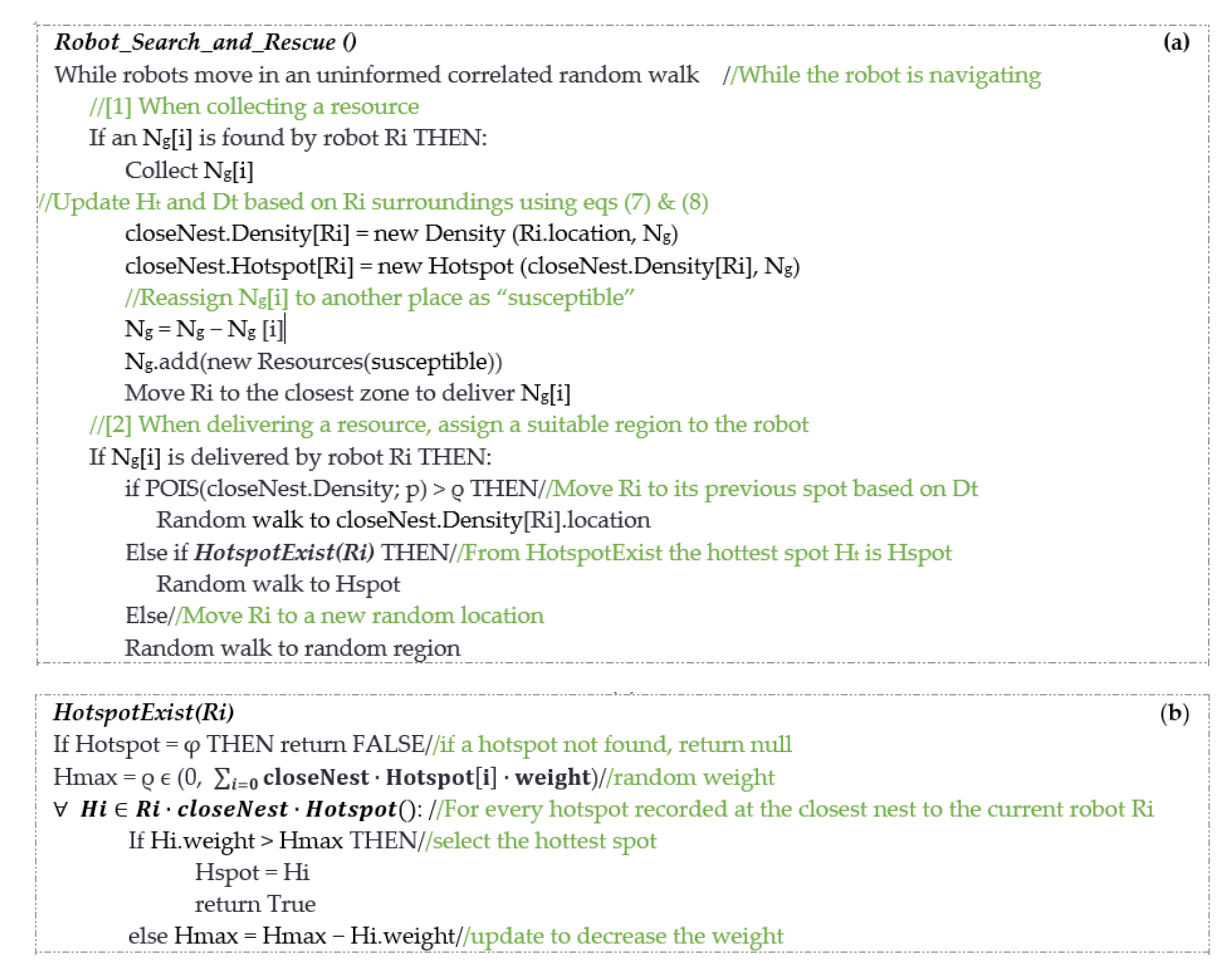
Figure 2. ED_Foraging “Hotspot DTA functions”. ( a ) Important actions performed by the robot during its search; ( b ) Assigning a robot to a hotspot using its weight, initialized as H t .